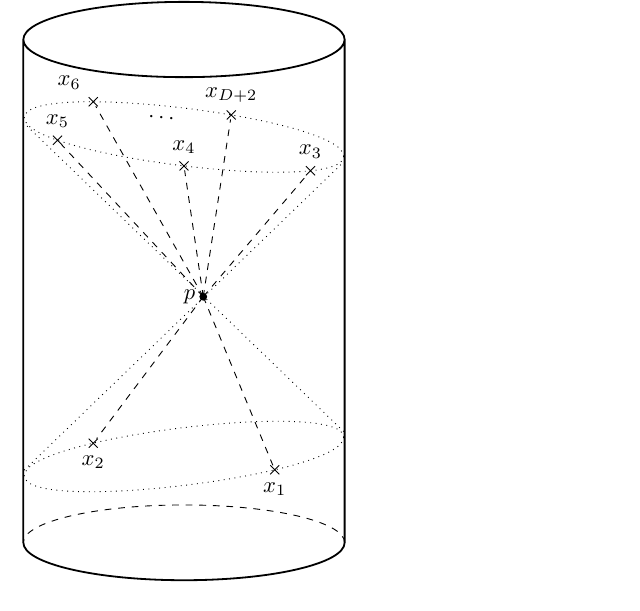
Figure 2 . Position-space Landau diagram for a boundary correlator with a bulk-point singularity from p M used to obtain light-cone cuts from the dual (cid:12)eld theory. For a D -dimensional 2